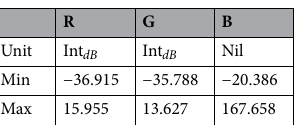
0 values in different